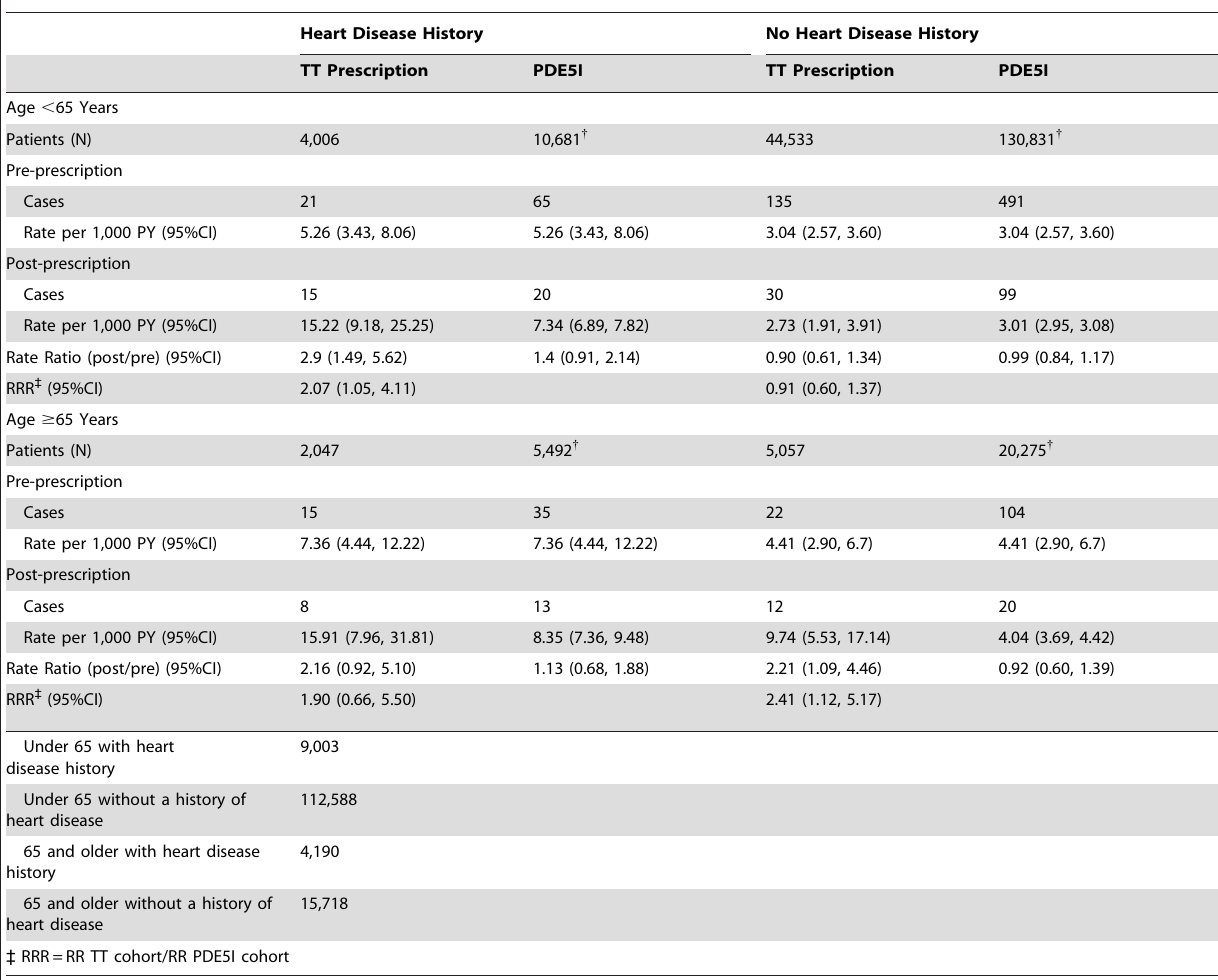
Table 4. Rates of myocardial infarction in men under and 65 and those 65 and older per 1,000 per year (PY) in pre- and post- prescription intervals for an initial prescription for TT or PDE5 inhibitors, with adjusted * rate ratios (RR), ratio of rate ratios (RRR) and 95% confidence limits (CL) by history of heart